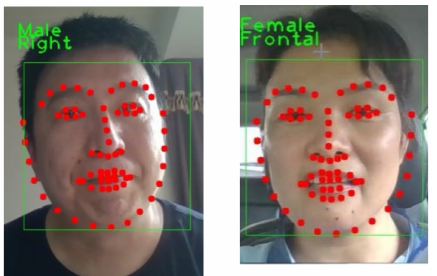
Figure 3. Facial landmarks with gender.